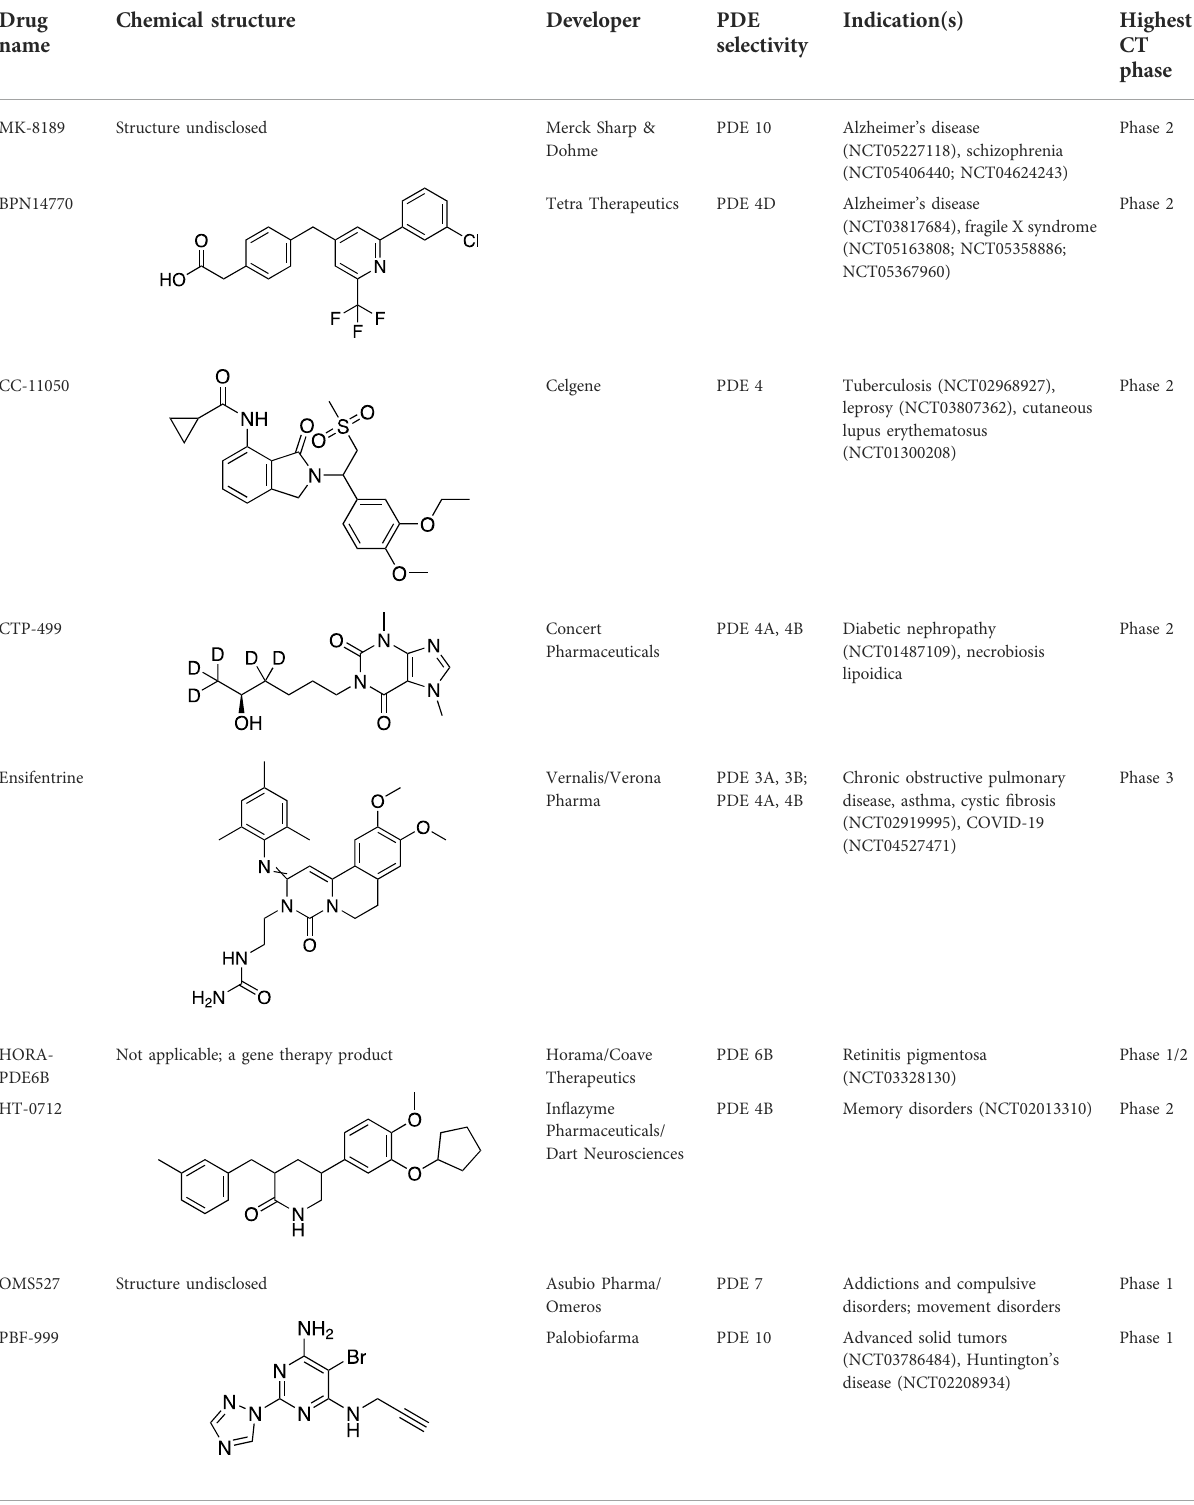
TABLE 5 Investigational PDE inhibitors in an ongoing clinical development. This table provides a summary on the novel PDE inhibitors that are currentlyinvestigatedinclinicaltrials. Theaggregated dataonindicationsandclinical trialsislistedasperstudiesidenti fi edonClinicalTrials.gov, the EU Clinical Trials register and/or the developers ’ websites. Chemical structures are derived from the PubChem database (Kim et al., 2021). Developer names are listed according to the relevant studies. Development status is listed according to the AdisInsight database., 2022 records 11